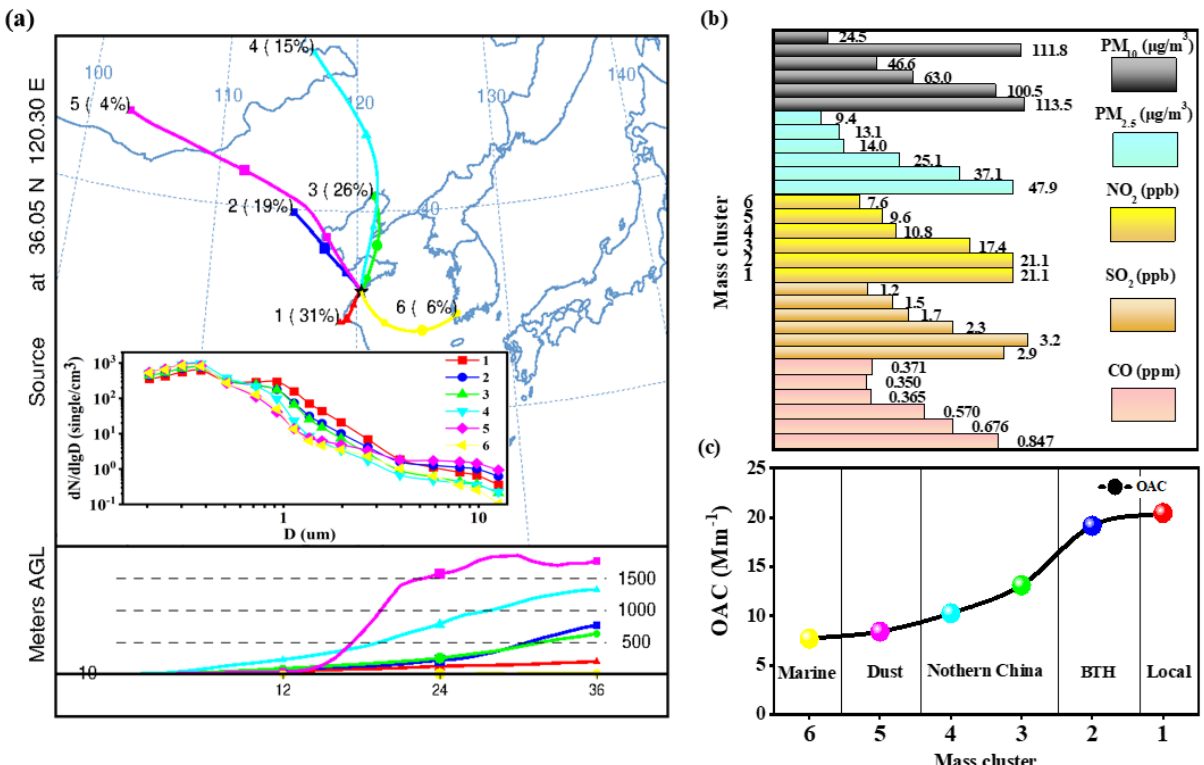
Figure 3. ( a ) Backward trajectory and size spectrum distribution of six kinds of air masses; ( b , c ) pollutant concentration and OACs of each source.